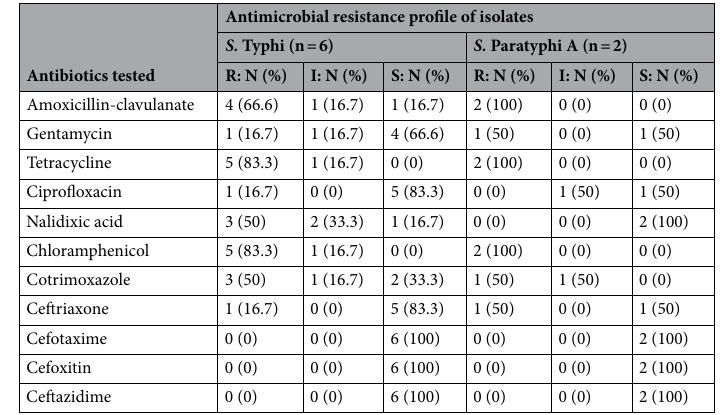
Table 2. Antimicrobial resistance pattern of S. Typhi and S . Paratyphi A isolated from study participants (n = 150) attending at FHSCH, Bahir Dar, Northwest Ethiopia, 2020. R resistant, I Intermediate, S Sensitive N number of isolates.